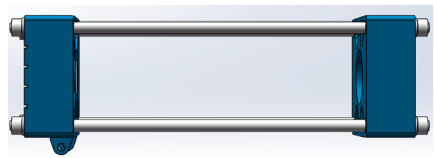
Figure 6: Structure of the main